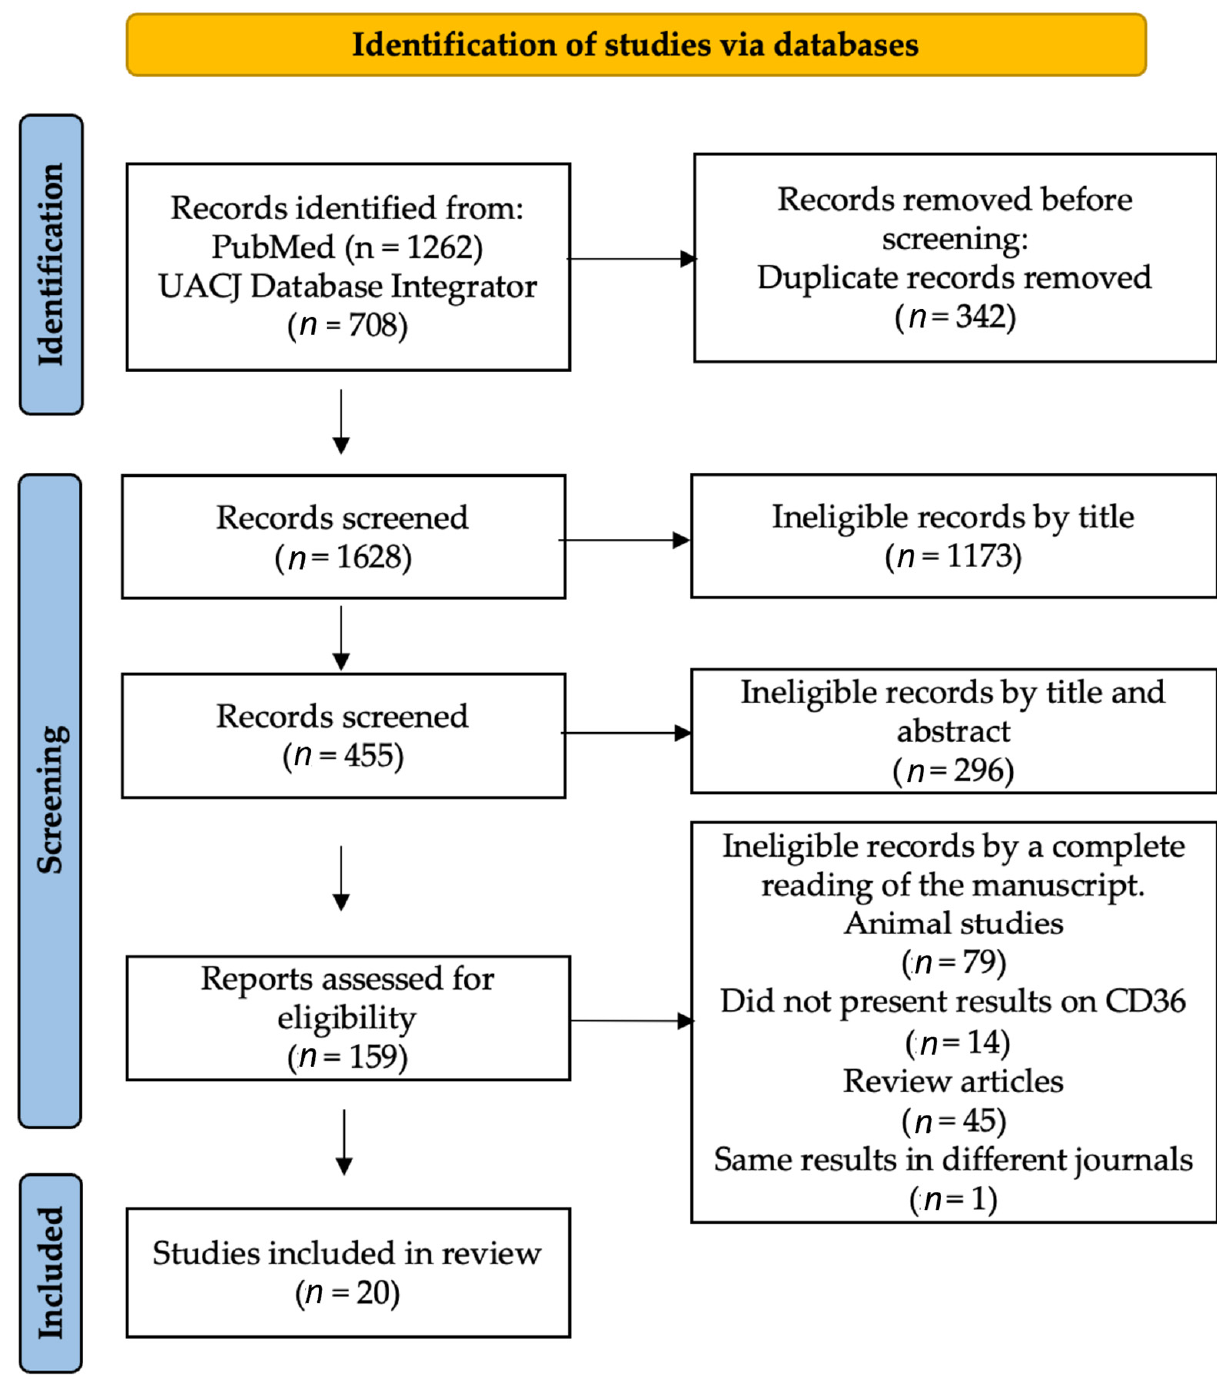
Figure 1. Flow of information through the different phases of a systematic review.